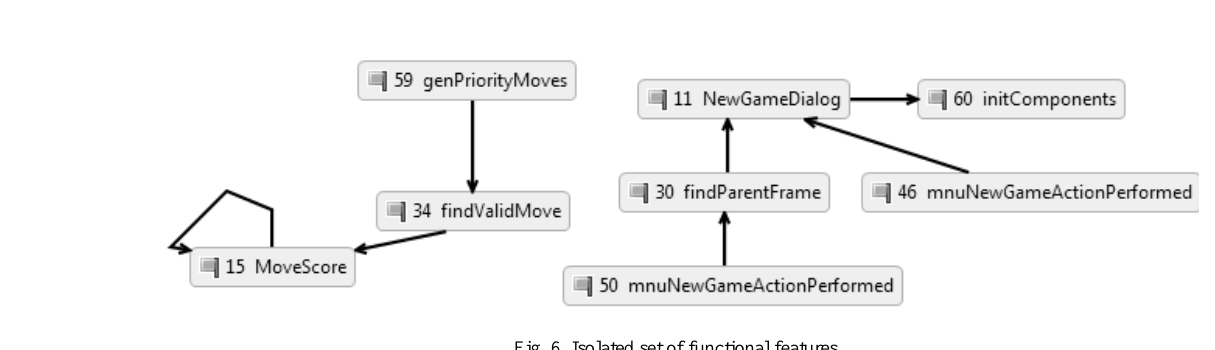
Fig. 6. Isolated set of functional features.